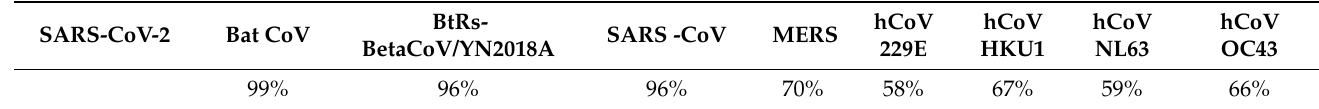
Table 1. Percentage of RdRp identity related to SARS-CoV-2 and different family of Coronavirus. Sequence reference are